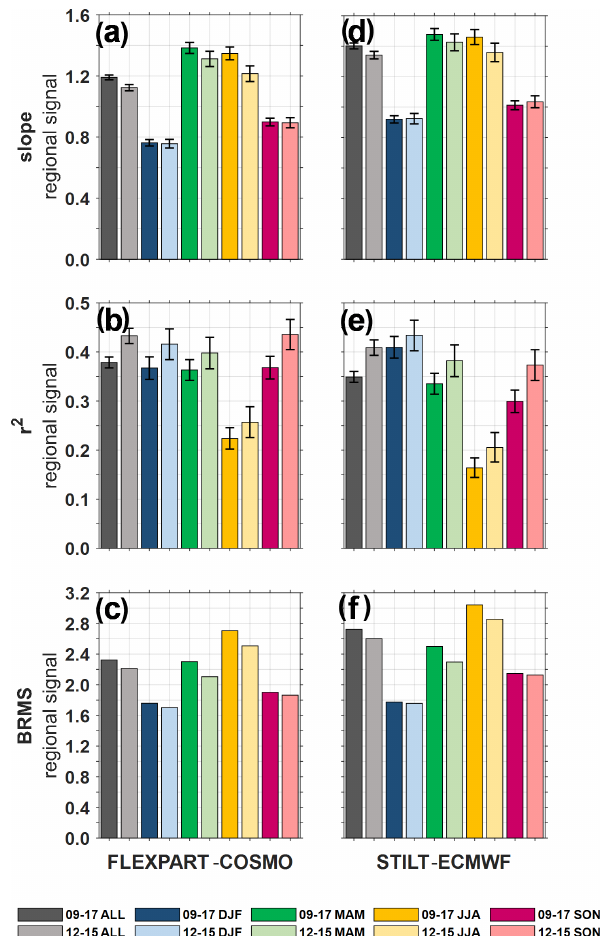
Figure 4. Summary of the regression analysis of CO 2 .regional sim- ulations vs. observation (data are based on 3-hourly time resolu- tion; error bars show the 95% confidence interval). The parameters (slope, r 2 and bias-corrected RMSE, i.e. BRMS) are presented for FLEXPART–COSMO ( a–c ) and STILT-ECMWF ( d–f ), including the full observation period, 2009–2017, and a 4-year subset (2012–